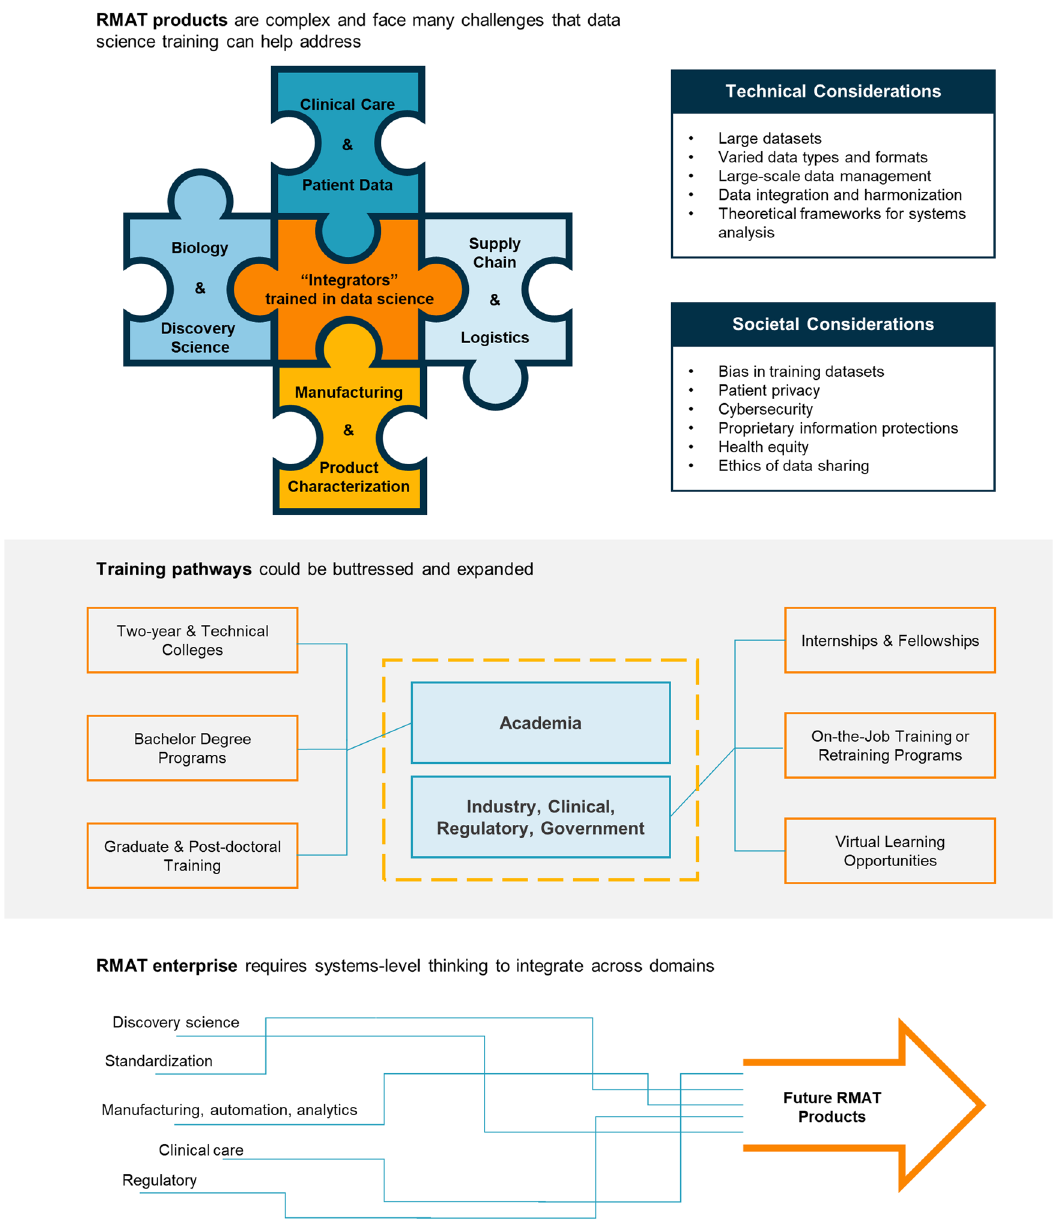
Fig. 1 Summary of the role of data science training in the future of RMAT workforce development. The role of data science training in the future of RMAT workforce development. Like a puzzle piece joining parts of a whole, data science can help to connect areas such as clinical care, discovery science, and manufacturing in the fi eld of RMAT. Training can take many forms, including both academic paths and others. Systems-level thinking could enhance the development of new RMAT